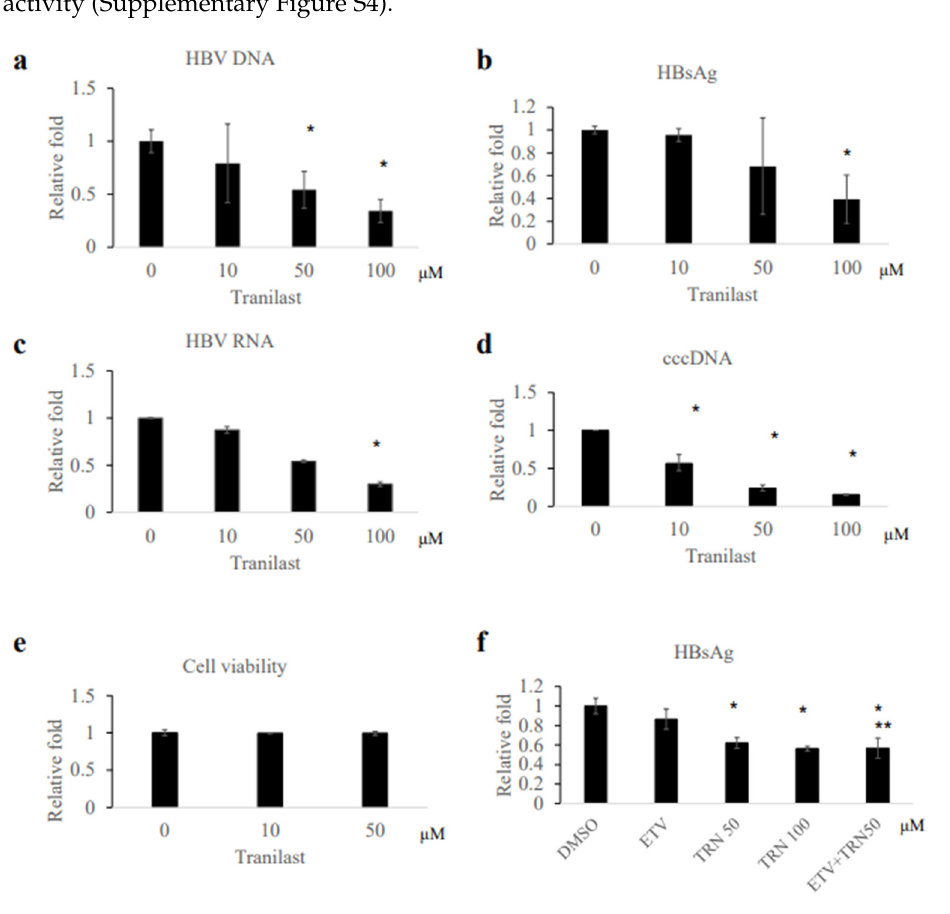
Figure 3. Effect of tranilast on HBV infection in human hepatocytes. ( a – d ) Human hepatocytes, PXB cells were infected with HBV and treated with the compound at the indicated concentration. At day 7, HBV DNA in the medium, HBsAg in the medium, intracellular HBV RNA level, and intracellular cccDNA level were measured. Experiments were performed in duplicate. ( e ) Cell viability on day 7 was determined by cell proliferation assay. Data were expressed as mean and standard deviation ( n = 4). ( f , g ) and PXB cells were infected with HBV and cultured. On day 14, the indicated concentration of tranilast or entecavir (0.1 μ M) was added for 7 days. Note that the peak plasma concentration of entecavir is 0.02–0.04 μ M in the clinical setting [22]. On day 21, the HBsAg level and HBV DNA level in the culture medium were determined. The data were expressed as mean and standard de- viation ( n = 4). ( h ) Cell viability on day 21 was determined by cell proliferation assay. The data were expressed as mean and standard deviation ( n = 4). * p < 0.05 compared to the control. ** p < 0.05 compared to entecavir alone. ETV, entecavir; TRN, tranilast. 2.6. The Effect of Tranilast on HBx-Induced Transcriptional Activity The transcriptional activity of HBx has been important for HBV replication [20]. Be- cause tranilast showed binding interaction with HBx, the effect of the compound on HBx’s